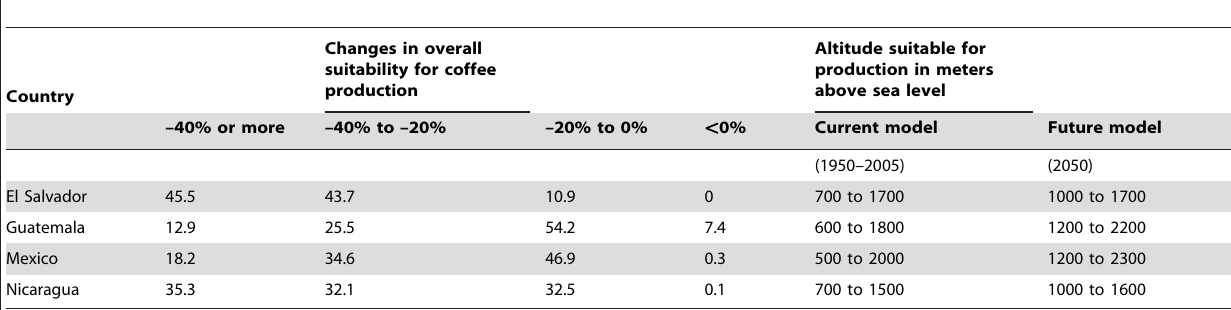
Table 2. Projected changes in overall suitability for coffee production and altitudinal range suitable for production in Mesoamerica by 2050.